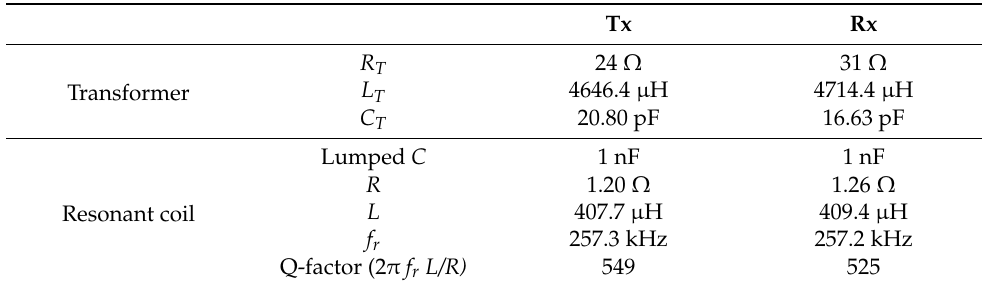
Figure 5. Photograph of the fabricated WPT system using both Tx and Rx transformers.